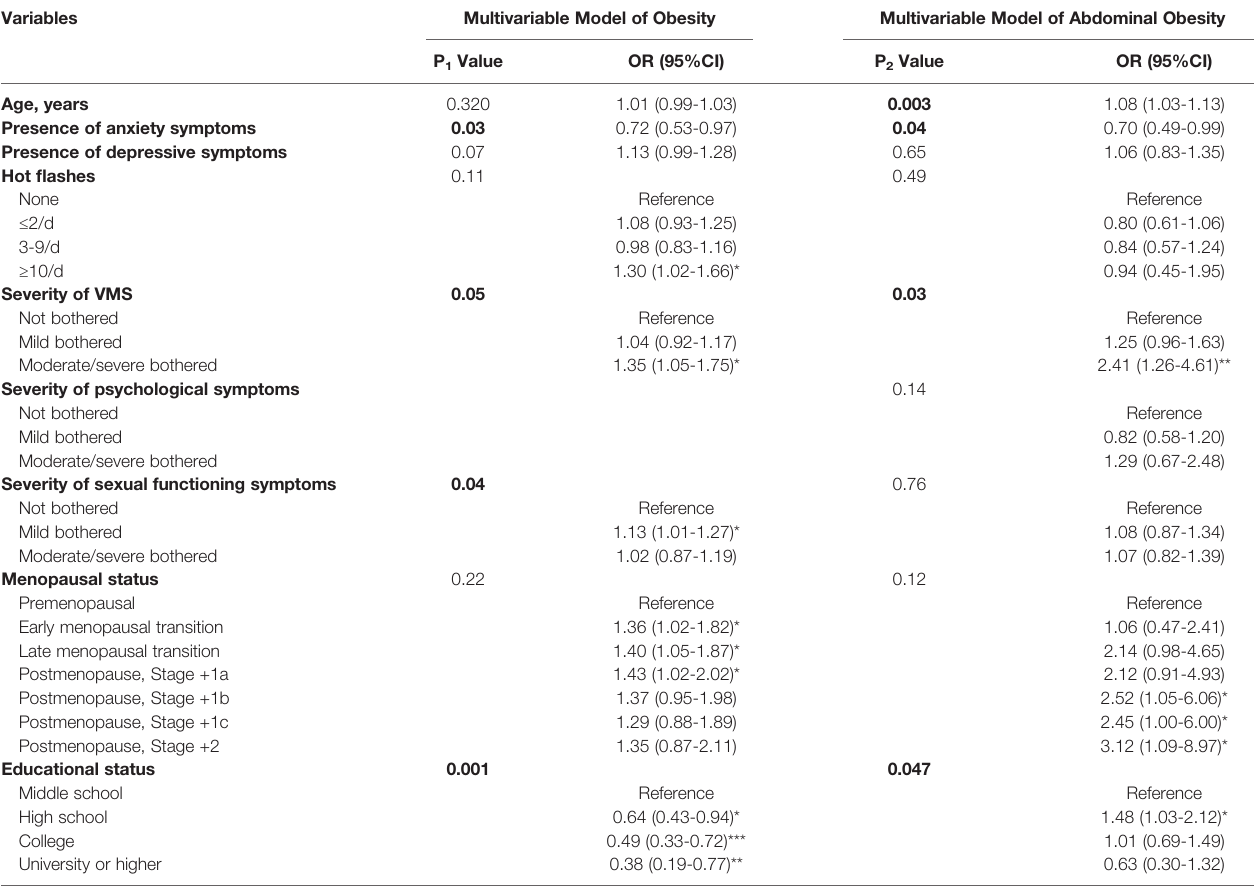
TABLE 2 | Multivariate associations of risk factors with obesity and abdominal obesity during 10 years follow-up.